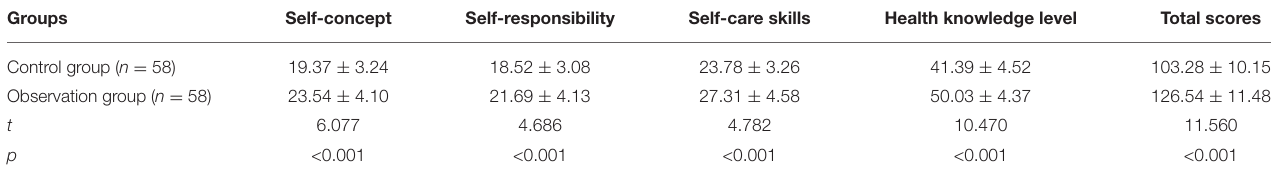
TABLE 2 | Comparison of Exercise of Self-Care Agency (ESCA) scores between the two groups of patients (¯x ± s, points).